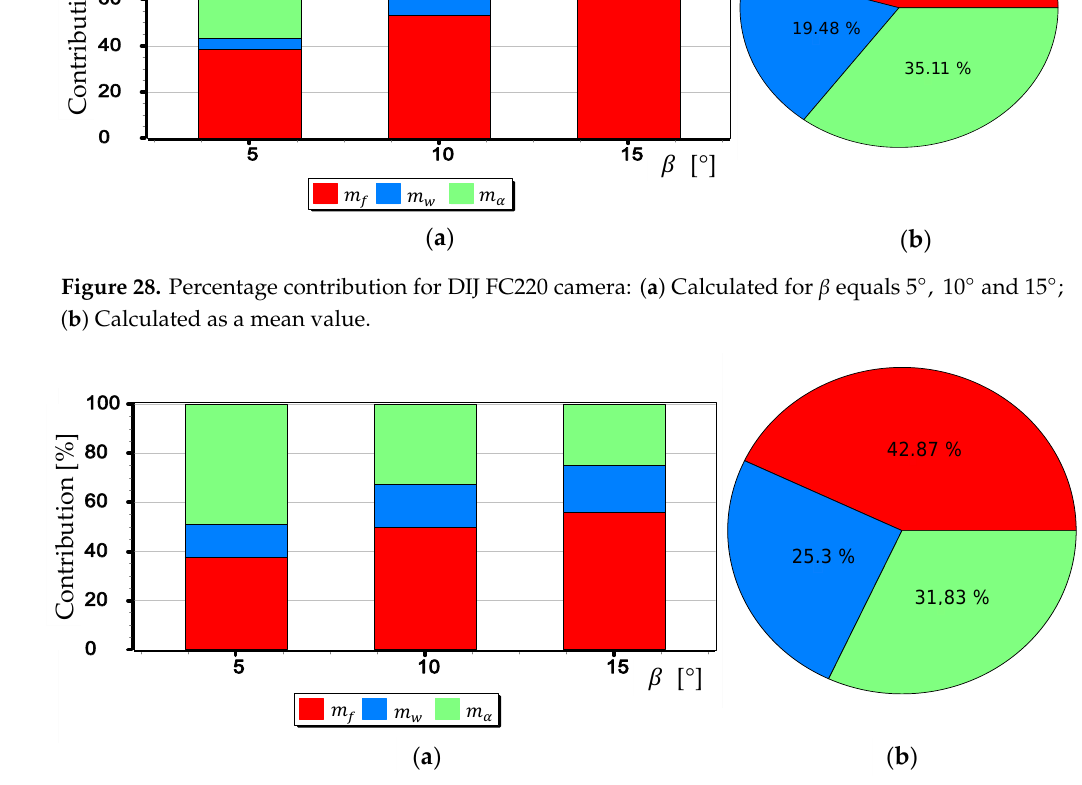
Figure 30. Percentage contribution for DIJ FC550RAW camera: ( a ) Calculated for 𝛽 equals 5°, 10° and 15° ; ( b ) Calculated as a mean value. Based on the graphs presented in Figures 27 – 30, two generalized conclusions can be made: •